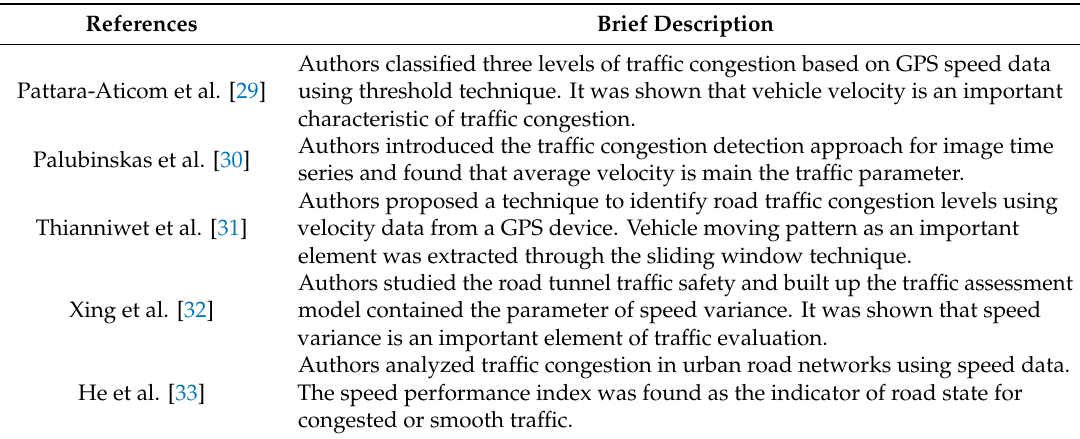
Table 1. Speed as an indicator of tra ffi c congestion